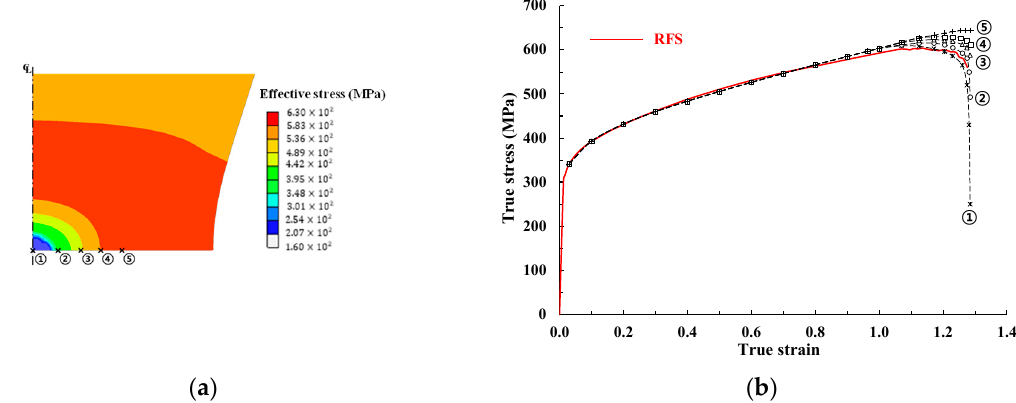
Figure 9. Effect of damage and initiation of fracture. ( a ) Definition of selected points and the effective stress at the fracture instant; ( b ) change of effective stresses at the selected points with true strain.